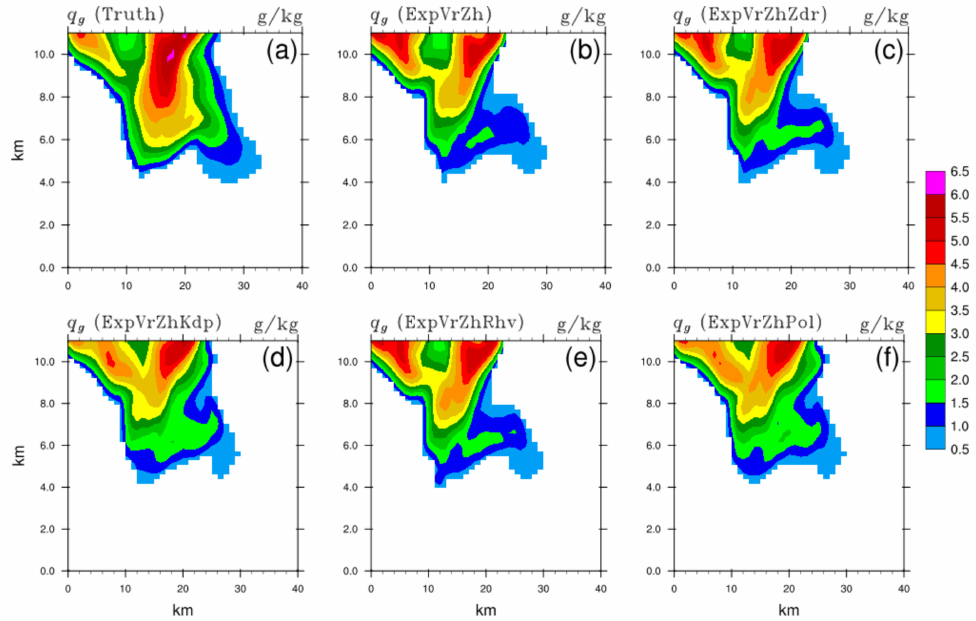
Figure 14. The same as Figure 7, but for the mixing ratio of graupel q g (unit: g/kg) of ( a ) truth, and analysis fields of ( b ) ExpVrZh, ( c ) ExpVrZhZdr, ( d ) ExpVrZhKdp, ( e ) ExpVrZhRhv, and ( f ) ExpVrZhPol,